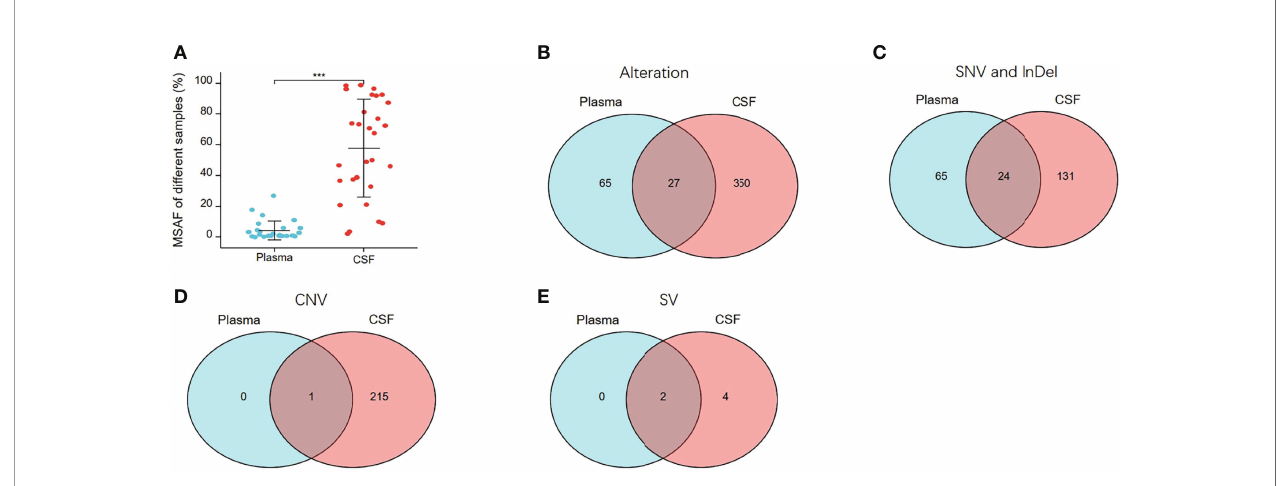
FIGURE 7 | MSAFandconcordanceof32pairedCSFandplasmasamples. (A) MSAFof32pairedCSFandplasmasamplesfrom 28treated-patients. (B) Theconcordance ofCSFandplasmasamplesfor detectionofallalterations. (C) The concordanceofCSFandplasmasamples fordetectionofSNV or InDel. (D) TheconcordanceofCSFand plasmasamplesfordetectionofCNV. (E) TheconcordanceofCSFandplasmasamples fordetectionofSV. ***p<